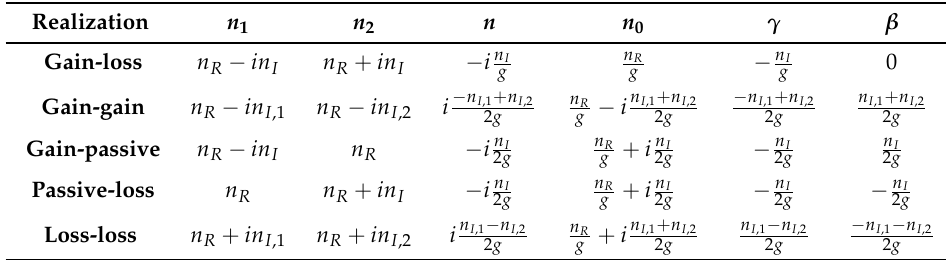
Table 1. A summary of the parameters involved in the different feasible experimental realizations of the -symmetric dimer PT